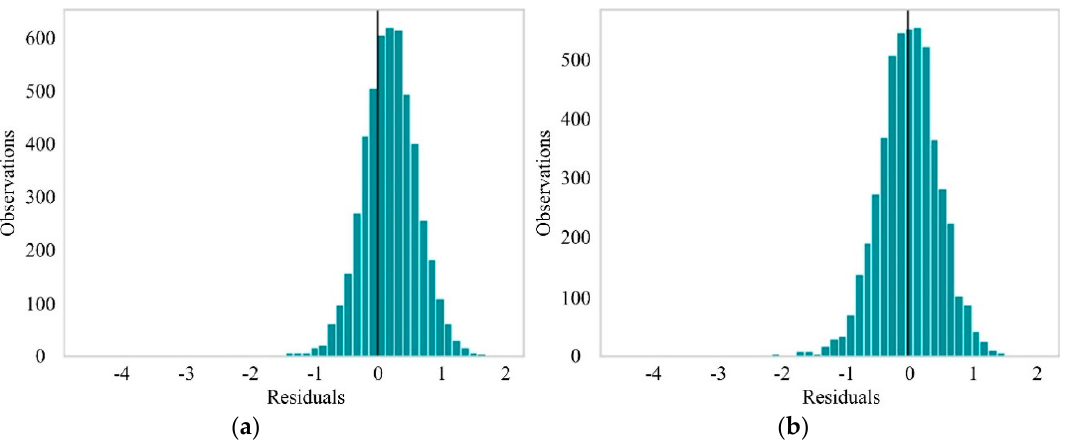
Figure 5. Error histograms of predictions from different loss functions ( Δ = 0.1). ( a ) LightGBM with early stopping, custom loss and custom validation loss. ( b ) default LightGBM.